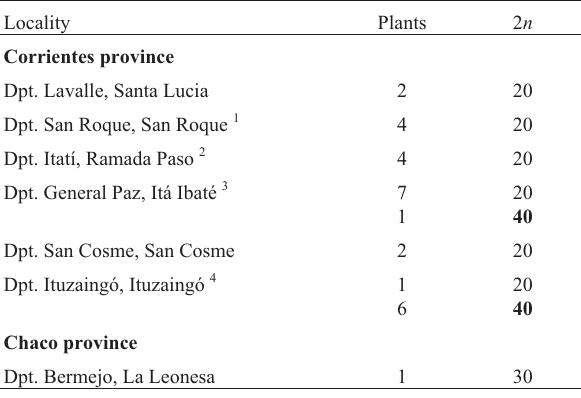
Table 1 - Collection sites and ploidy levels of plant materials.